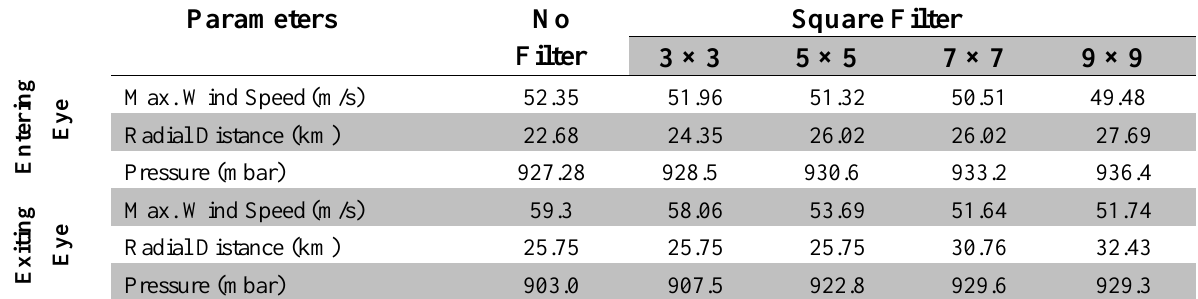
Table 1. Pressure depression for box-car filters of varying spatial